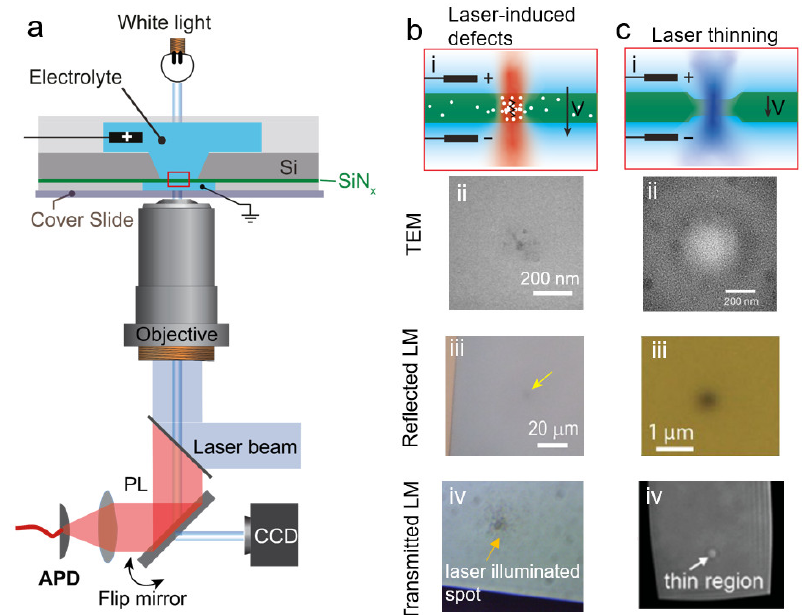
Figure 3. Laser-assisted breakdown to form nanopores locally. ( a ) Schematic of the experimental setup for laser-assisted breakdown. A collimated laser beam is focused on the membrane by an objective during the CBD process. The optical feedback signal, either PL intensity or Ca 2+ flux fluorescence, is collected by the objective and received by a camera. Adapted with permission from Ref. [10]. Copyright 2018 American Chemical Society. ( b ) Laser-induced defect accumulation. The laser illumination enhances the defect density locally as ( i ) white dots. This defect accumulation appears as a dark spot in a TEM image ( ii ). This region has a lower reflection and transmission due to the high absorbance, therefore appears black in both reflected ( iii ) and transmitted ( iv ) light microscopy images. ( c ) Laser thinning. The focused laser illumination etches the membrane on both sides ( i ). The thinned region appears white in a TEM image ( ii ). Light microscopy images show a dark spot in reflection ( iii ) and a white spot in transmission ( iv ). Adapted with permission from Ref. [10]. Copyright 2018 American Chemical Society. Adapted with permission from Ref. [88]. Adapted with permission from Ref. [89]. Copyright 2018 American Chemical Society.